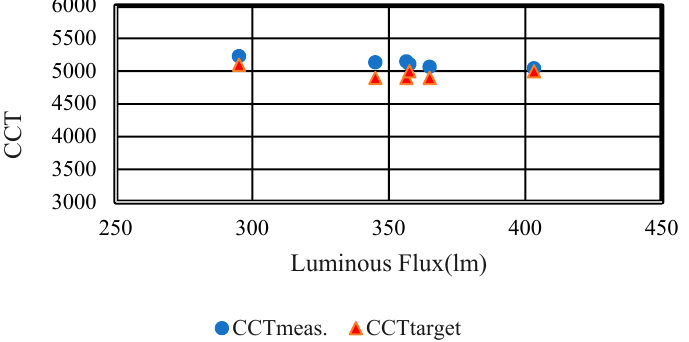
Figure 7. Variation in CCT with the change in luminosity of the composite LED light.